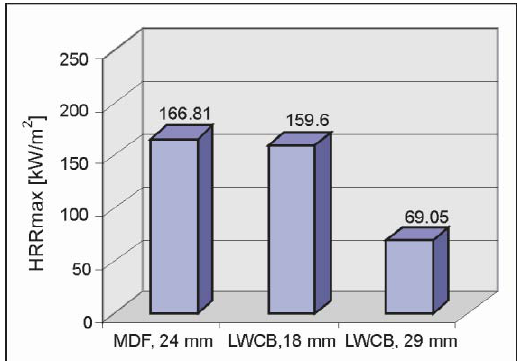
Fig. 5. The mean value of maximal heat release rate (HRR max ) when exposed to the surface heat flow density of 30 kW/m 2 for different tested